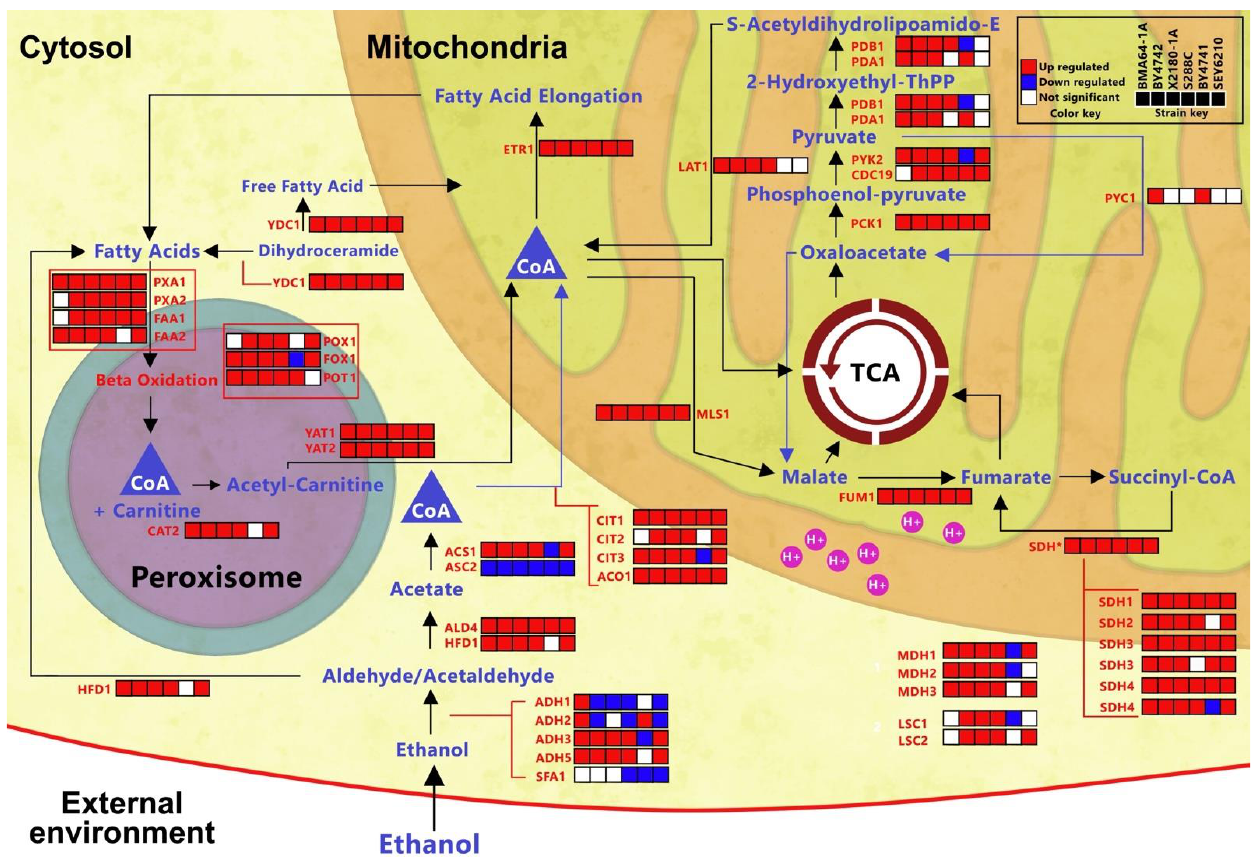
Figure 6. EtOH stress-buffering model based on the diauxic shift. The CoA indicates acetyl-CoA.